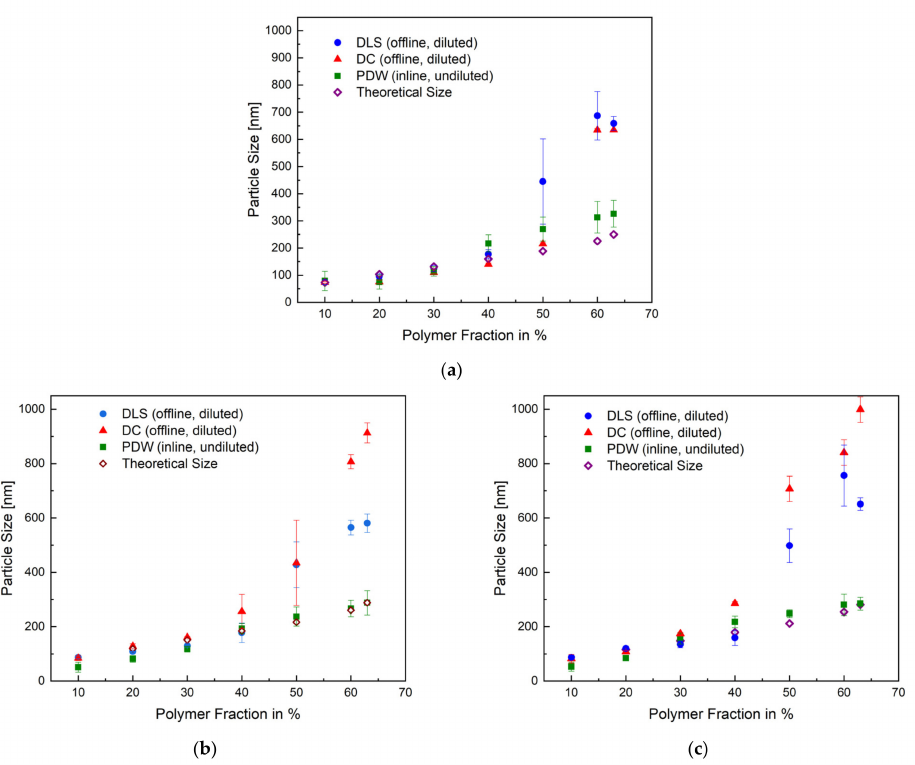
Figure 4. Overview of the measured mean particles size of all three measurements methods and the calculated theoretical size as a function of the polymer fraction with the respective standard deviation for the emulsion polymerisation in a 1 L ( a ), 10 L ( b ), and 100 L ( c ) reactor.